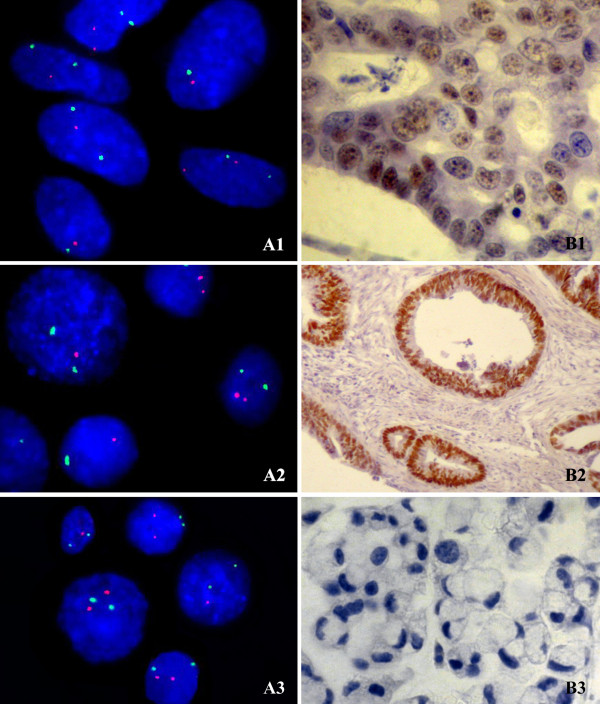
Cells submitted to FISH (A) and immunohistochemistry (B) assays. A1 (case 14), A2 (case 5) and A3 (case 6): interphase nuclei presenting chr17 monosomy (green signal) with one copy of TP53 (red signal), and nuclei presenting chr17 disomy with one or two copies of TP53 – 1000× magnification; B1 (case 14) and B2 (case 17): tissue with nuclear p53 immunoreactivity (brown stain) – 400× and 100× magnification, respectively; B3 (case 6): tissue without p53 immunoreactivity – 400× magnification.